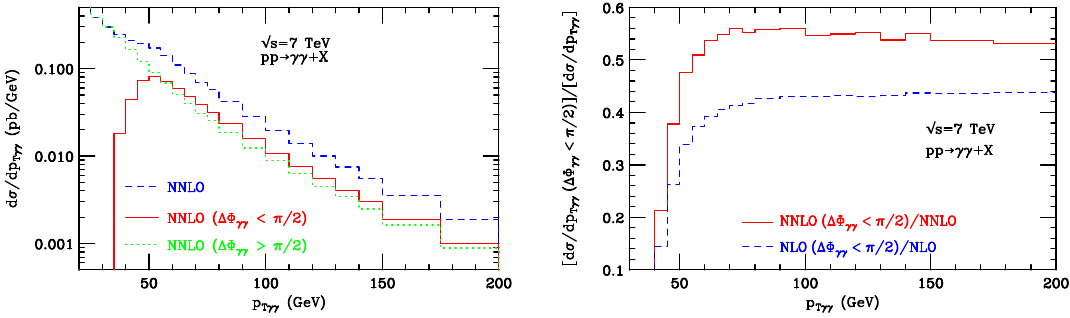
Figure 15 . Left panel: the NNLO cross section dσ/dp Tγγ (blue dashed) in figure 13-right and its partition into the contributions from the two complementary regions where ∆Φ γγ > π/ 2 (green dotted) and ∆Φ γγ < π/ 2 (red solid). Right panel: the fractional contribution to dσ/dp Tγγ from the region where ∆Φ γγ < π/ 2 at NLO (blue dashed) and NNLO (red